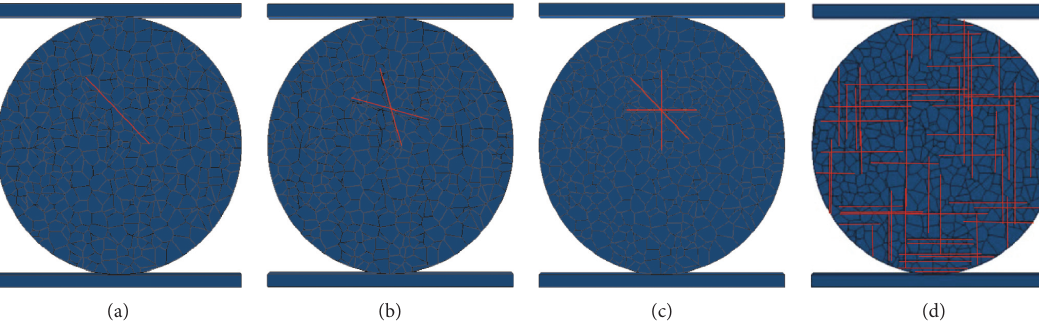
Figure 29: Shale model with natural fractures. (a) 1 crack. (b) 2 cracks. (c) 3 cracks. (d) Natural crack